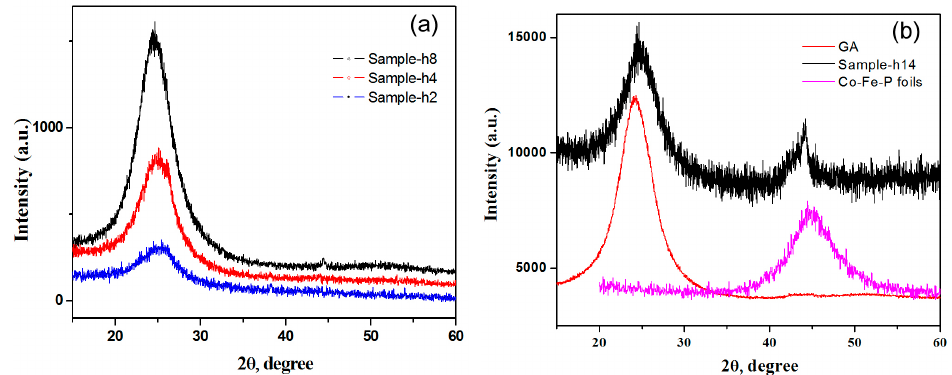
Figure 3. XRD patterns of GA and GA/Co-Fe-P samples: ( a ) Sample-h2, Sample-h4 and Sample-h8; ( b ) GA, Co-Fe-P foils and Sample-h14.